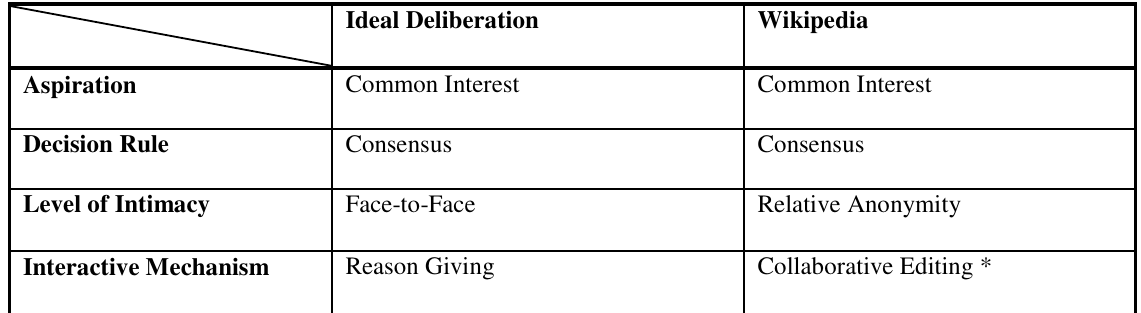
Figure 1: Adapted from Jane Mansbridge’s (1983) account of unitary and adversary democracy, this figure illuminates the primary features of ideal deliberation and Wikipedia’s collaborative editing. We borrow three of her criterion (assumption, decision rule, and level of intimacy) and add one of our own (interactive